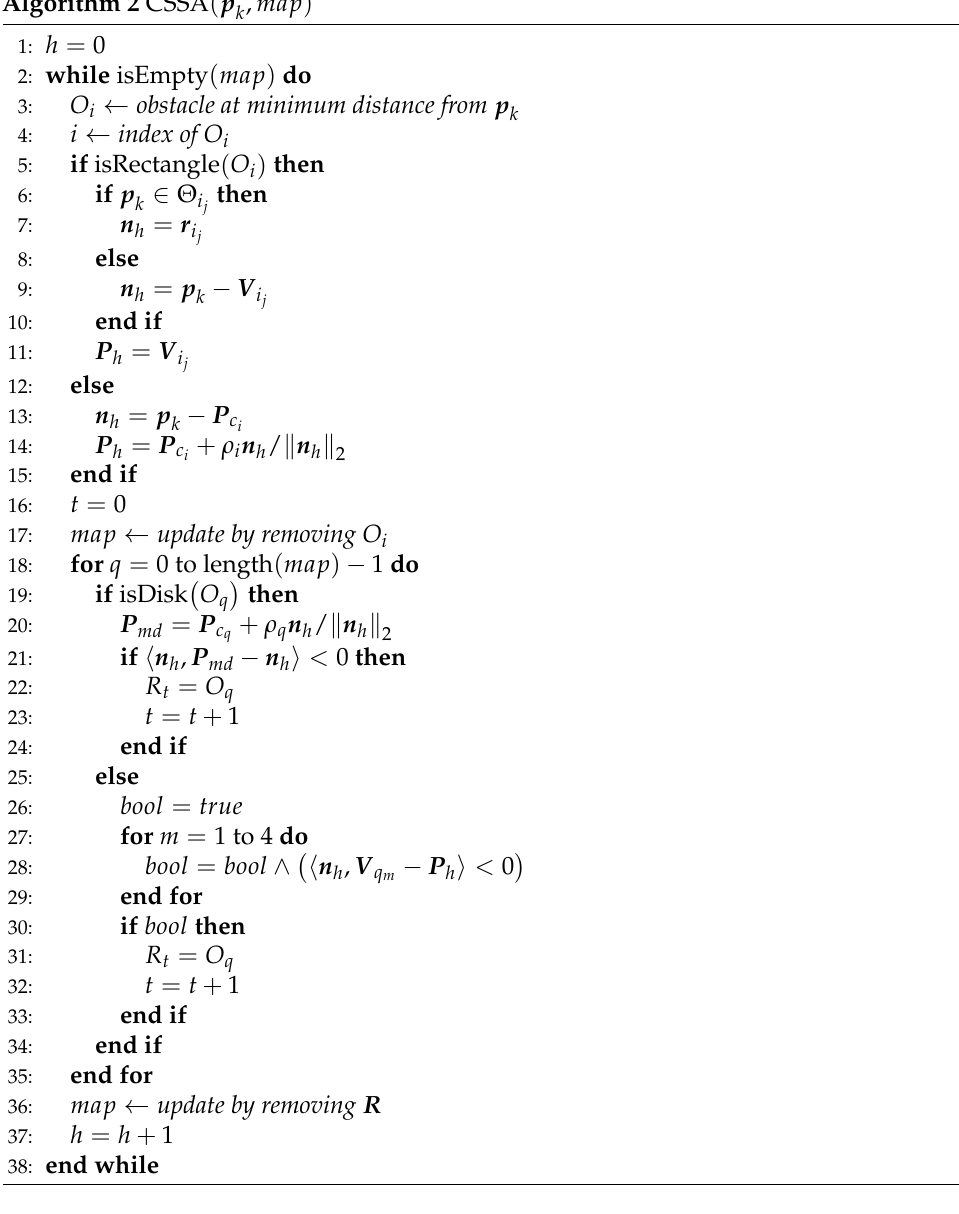
Algorithm 2 CSSA ( p